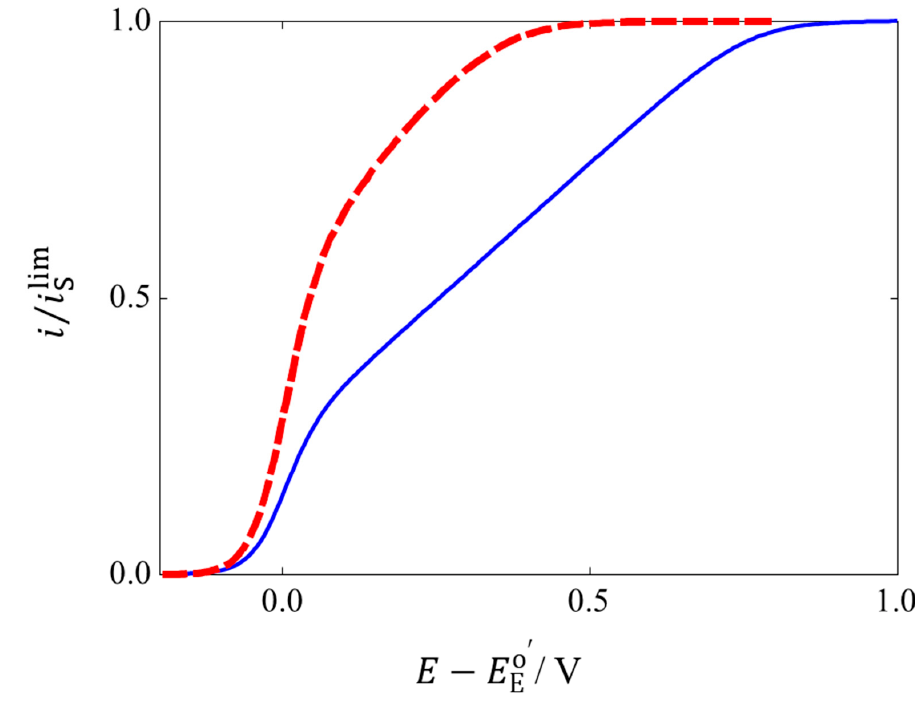
Figure 4. Steady-state bioelectrocatalytic voltammograms calculated for planar (solid line) and porous electrodes (dashed line). The parameters used are d min = 1.6 nm, d max = 2.6 nm, R enz = 2 nm, k c / k o max = 10 − 10 , and R p = 2.7 nm.